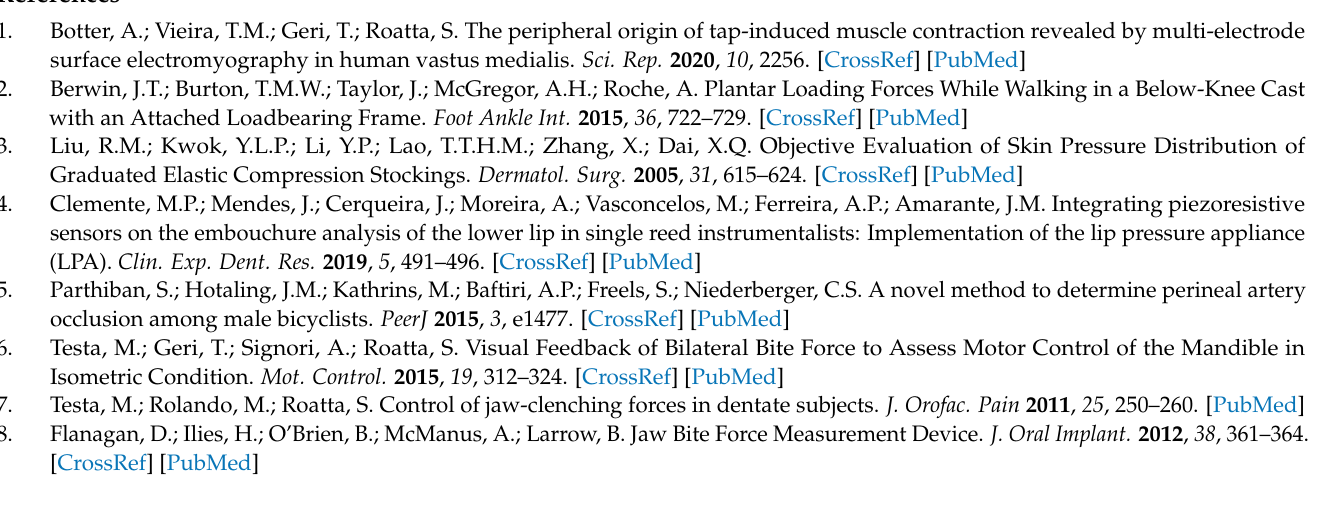
Figure S2: Detailed design of the housing.